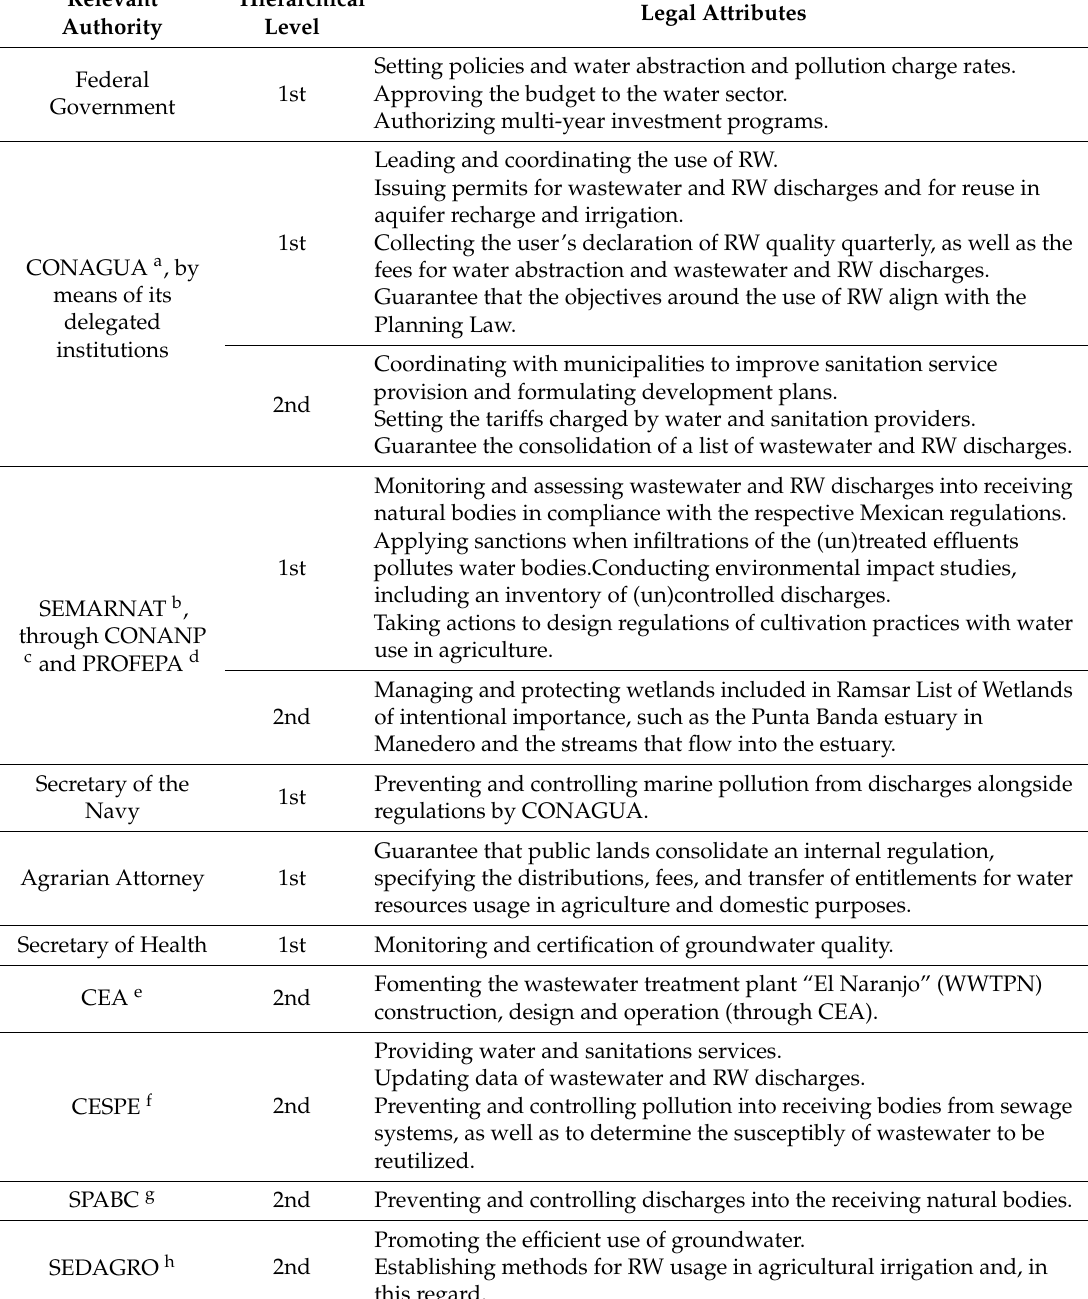
Table 1. Legal attributes of the relevant authorities in the water sector associated with wastewater and its